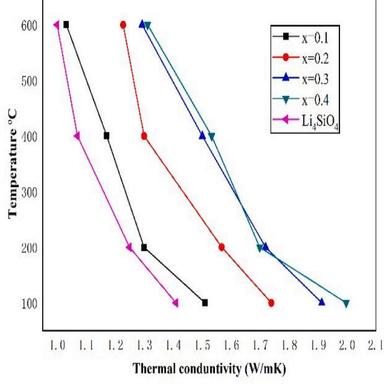
Thermal conductivity of the samples as a function of temperature.